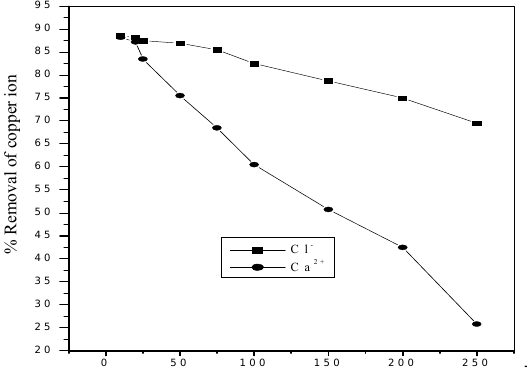
Figure 9. Effect other ions on the removal of copper ion by CBC [Cu]=30 mg/L; Adsorbent dose=25 mg/50 mL; temp=35 o C contact time = 60